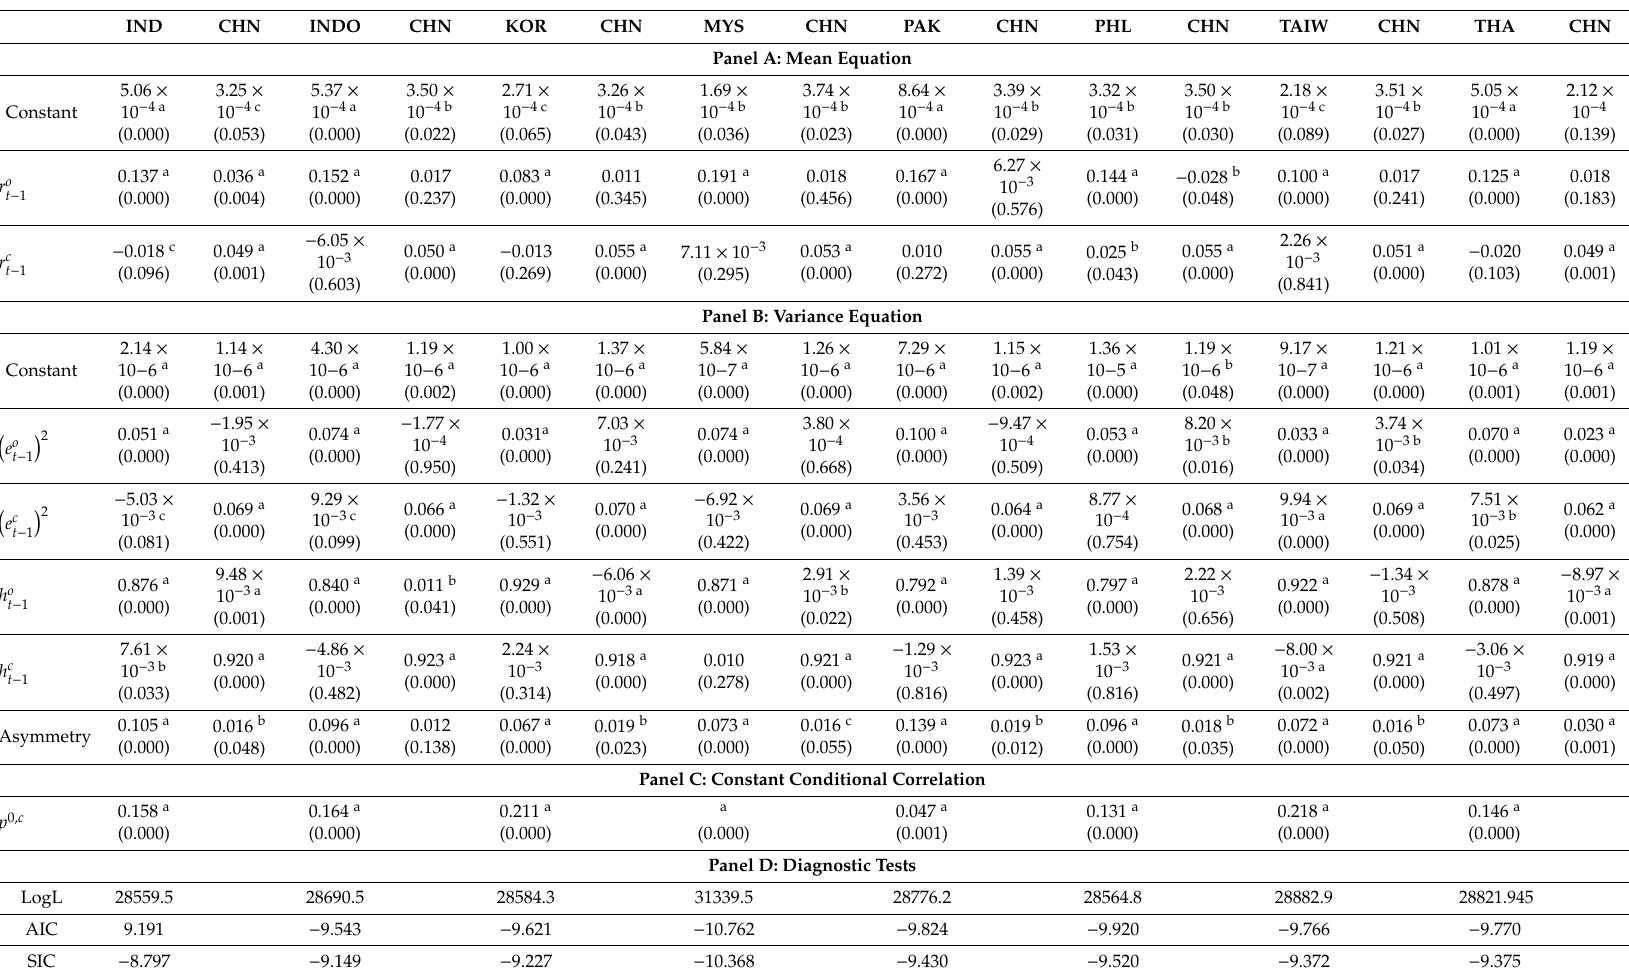
Table 3. Estimates of bivariate VAR − AGARCH for China’s and other Asian stock markets during the full sample